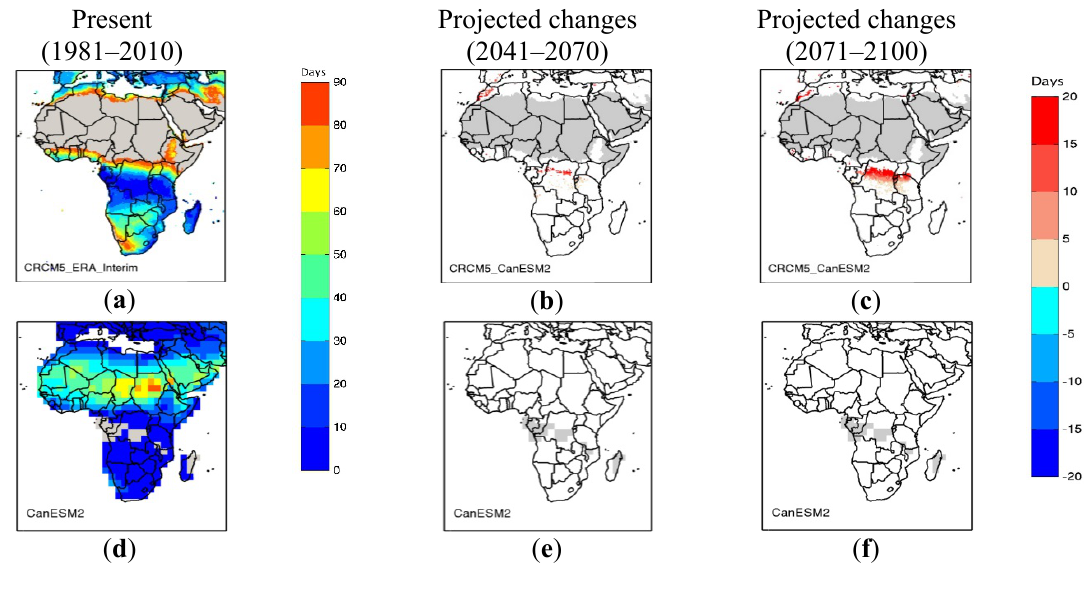
Figure 14. Same as Figure 13, but for the austral